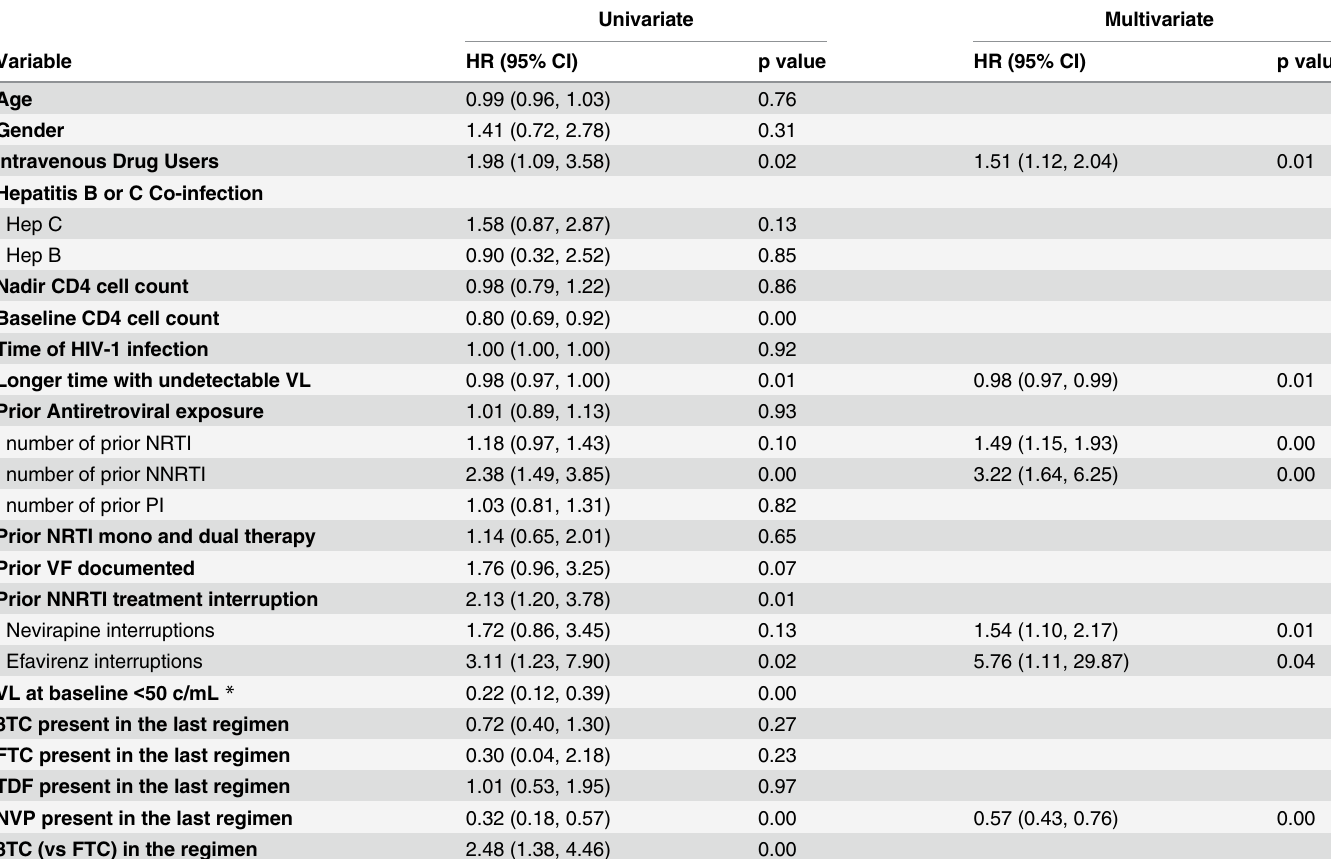
Table 2. Factors associated with virologic failure to a switch regimen composed of NVP plus TDF plus FTC (or 3TC) (n = 341).